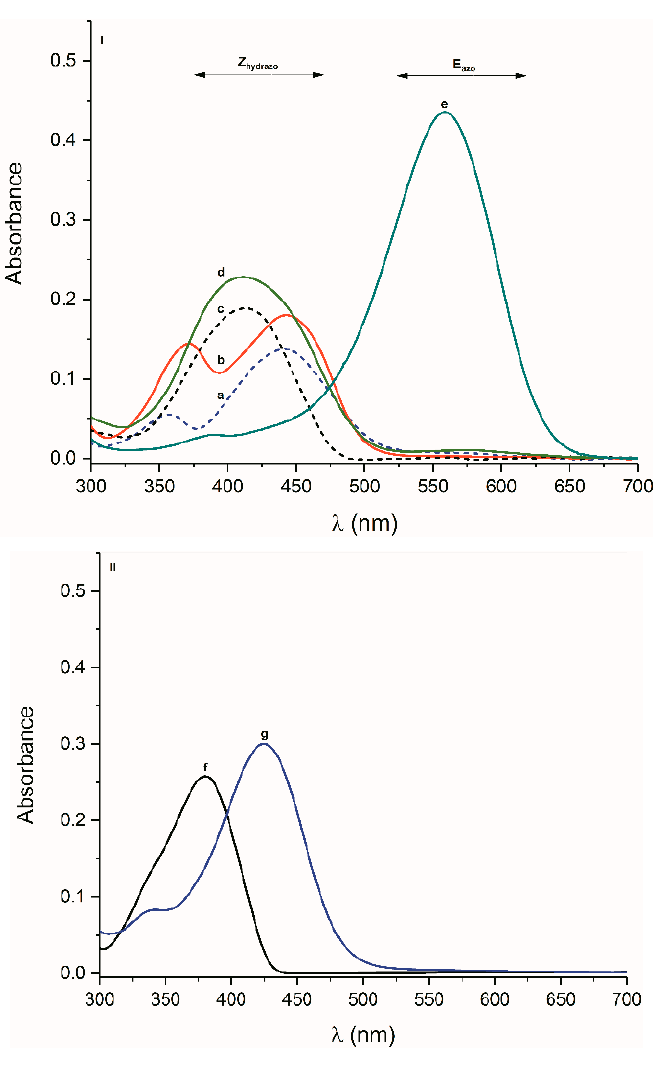
Figure 1. UV-Vis spectra of Z - and E -isomers (1 × 10 − 5 mol·dm − 3 ) of compounds: I) (a) 2 E , (b) 2Z , (c) 1 , (d) 3Z , (e) 3 E ; II) (f) 4 , (g) 5 in DMF. UV-Vis spectra of E - and Z -isomers of hydrazones 1 , 2 E , 2 Z 3 E and 3 Z , are dependent on their concentration (Figure 2; Supplementary Figure S1).